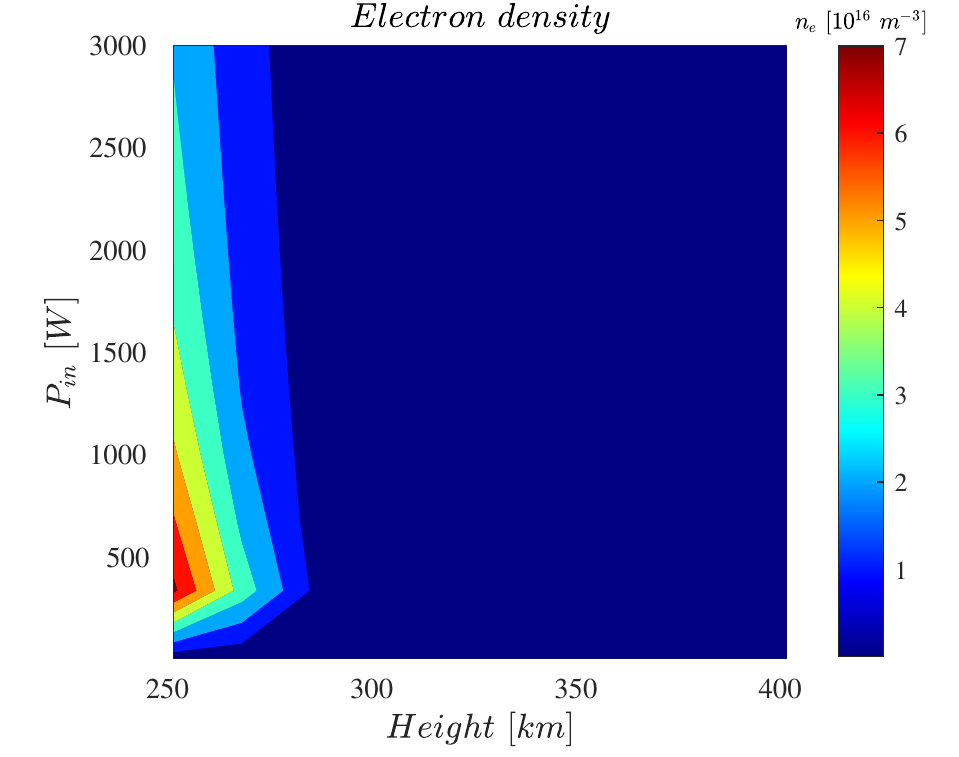
Figure 6. Plasma density as a function of the orbital altitude and input